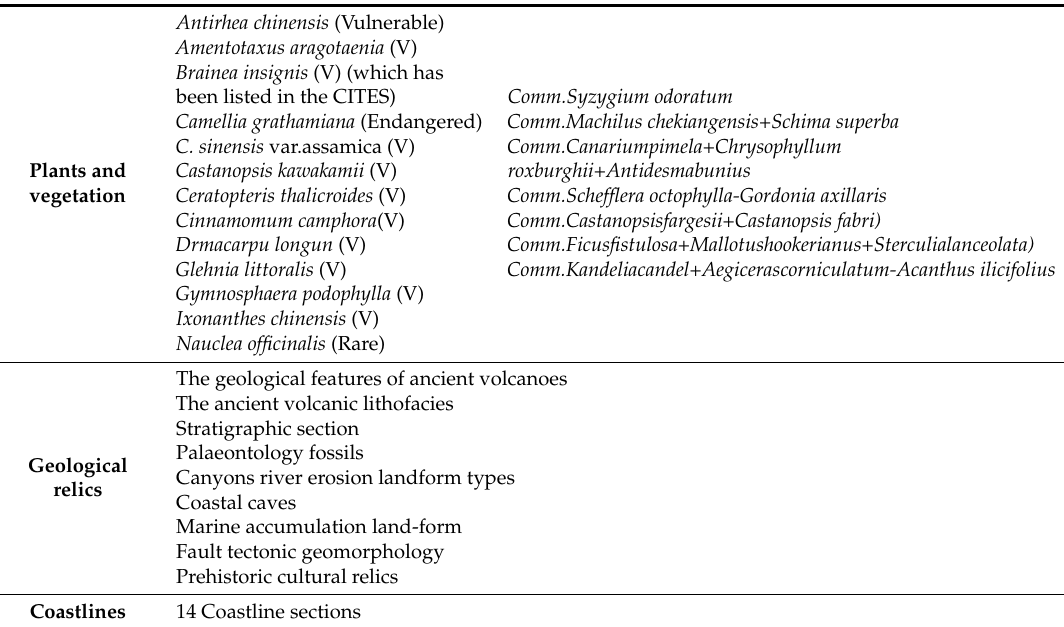
Table 1. Significant geological and ecological resources on the DP. (Source: author—compiled based on [18,45]). Italicize species